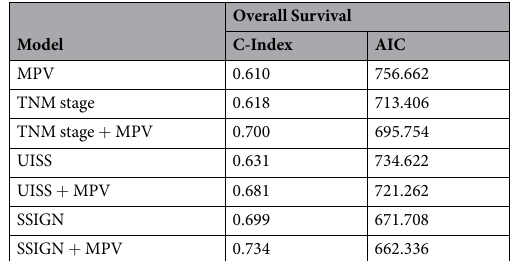
Table 5. Comparison of the prognostic accuracy of the prognostic models and MPV levels. MPV = Mean platelet volume, C-index = Harrell concordance index, AIC = Akaike information criteria, TNM stage = tumor, node and metastasis stage, SSIGN = the Mayo clinic stage, size, grade, and necrosis score, UISS = University of Los Angeles integrated staging